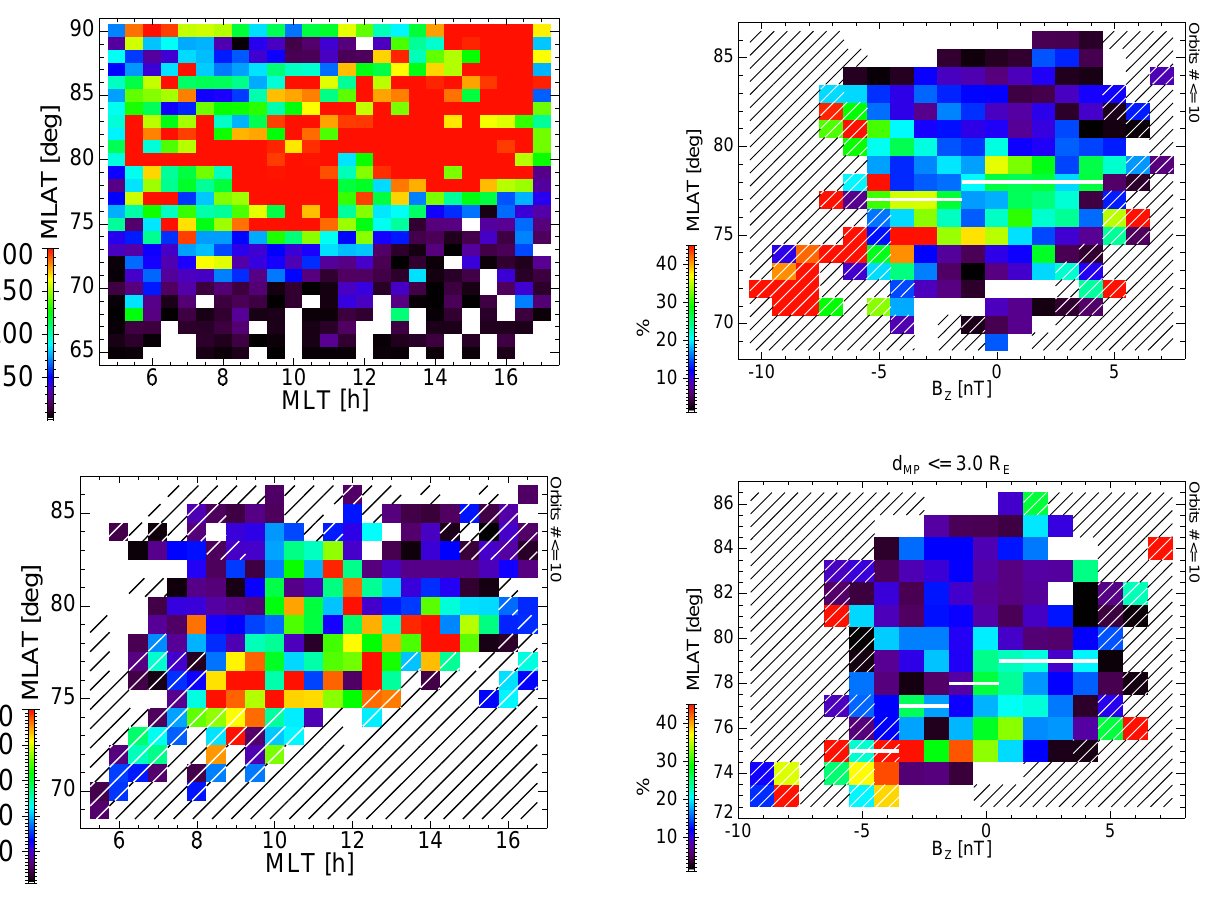
Fig. 3. The total observational coverage of the dayside auroral zone by the Magion-4 measurements mapped along magnetic field lines down to the Earth’s surface (top) and the ratio between the time of the cusp-like plasma observation and the total time of observation (bottom). Magion-4 passed not more than ten times through the hatched bins.